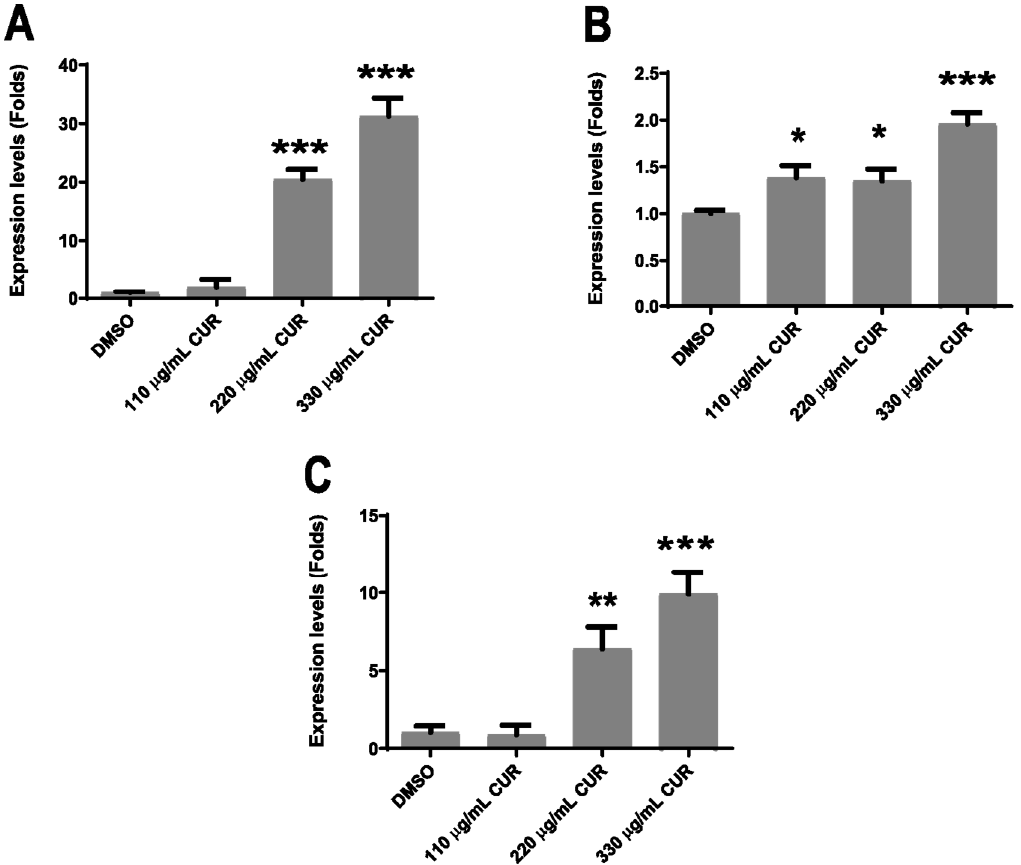
Figure 5. Relative–quantitative RT-PCR assay for fliC , siiE and invA after CUR treatment; S. enter- ica ser. Typhimurium siiE ( A ), invA ( B ) and fliC ( C ), mRNA expression levels (** p < 0.01, *** p < 0.001)